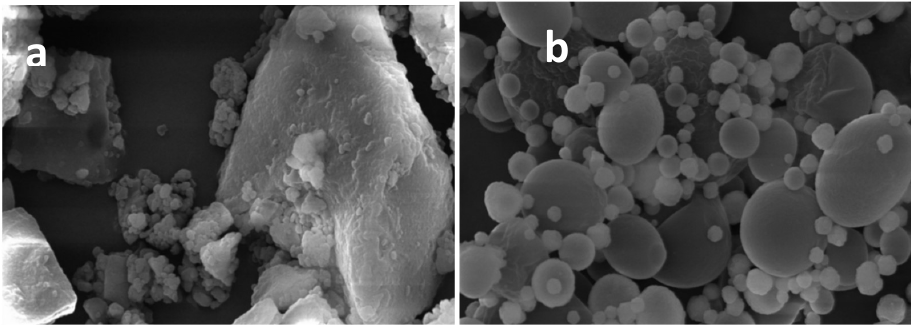
Figure 1. Scanning electron microscopy of MTE raw extract ( a ) and spray dried MTE_mp ( b ).